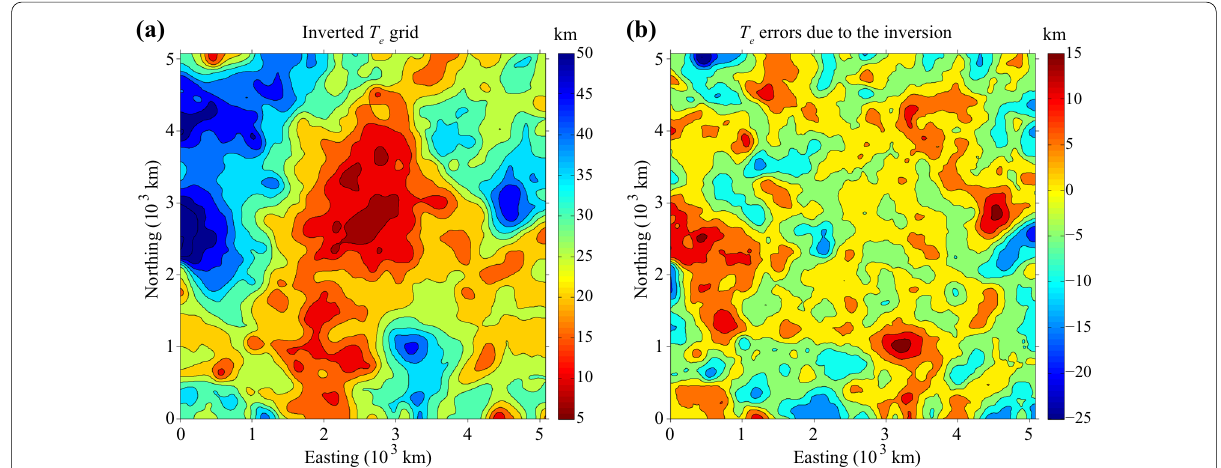
Fig. 4 a Inverted T e grid. b T e errors due to the